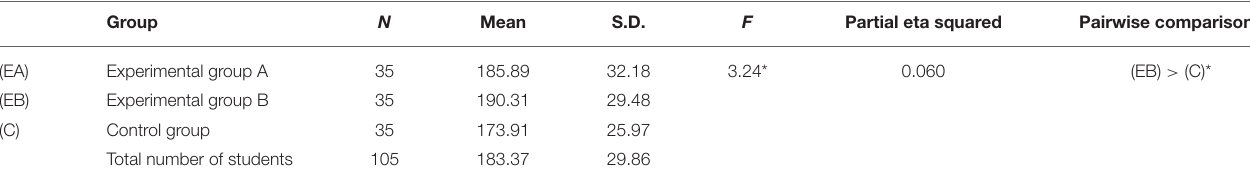
TABLE 4 | ANCOVA results of learning achievement on the post-test scores of the three groups. Group Experimental group A Experimental group B Control group